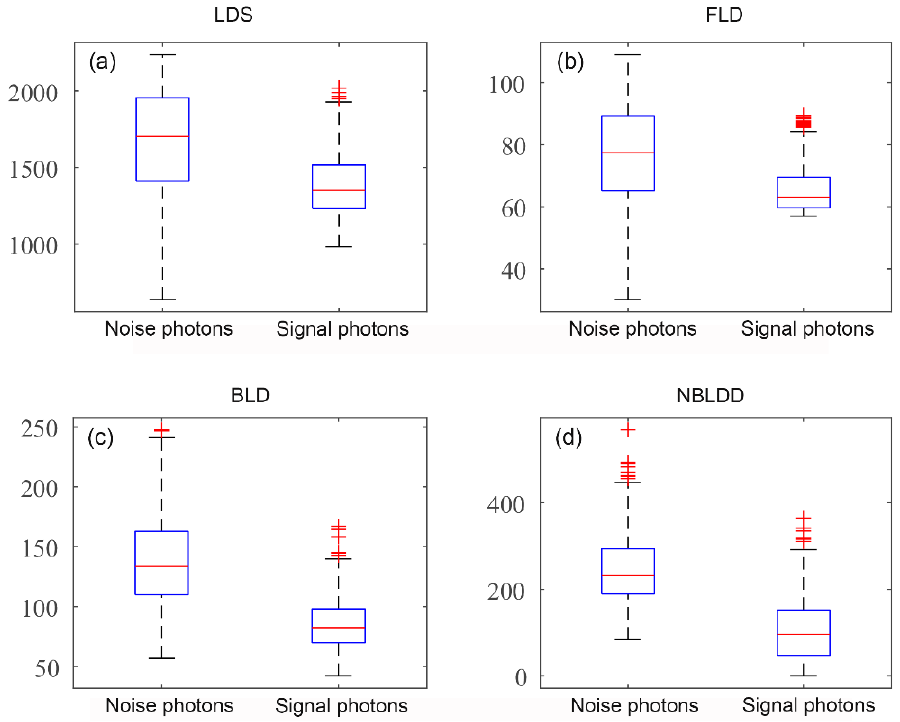
Figure 11. Local distance statistics results for ( a ) LDS, ( b ) FLD , ( c ) BLD , and ( d ) NFLDD